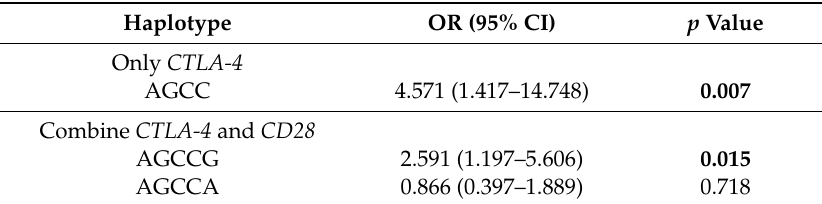
Table 5. The haplotype analysis of CTLA-4 (rs4553808, rs62182595, rs16840252, rs5742909) and CD28 (rs3181097) gene